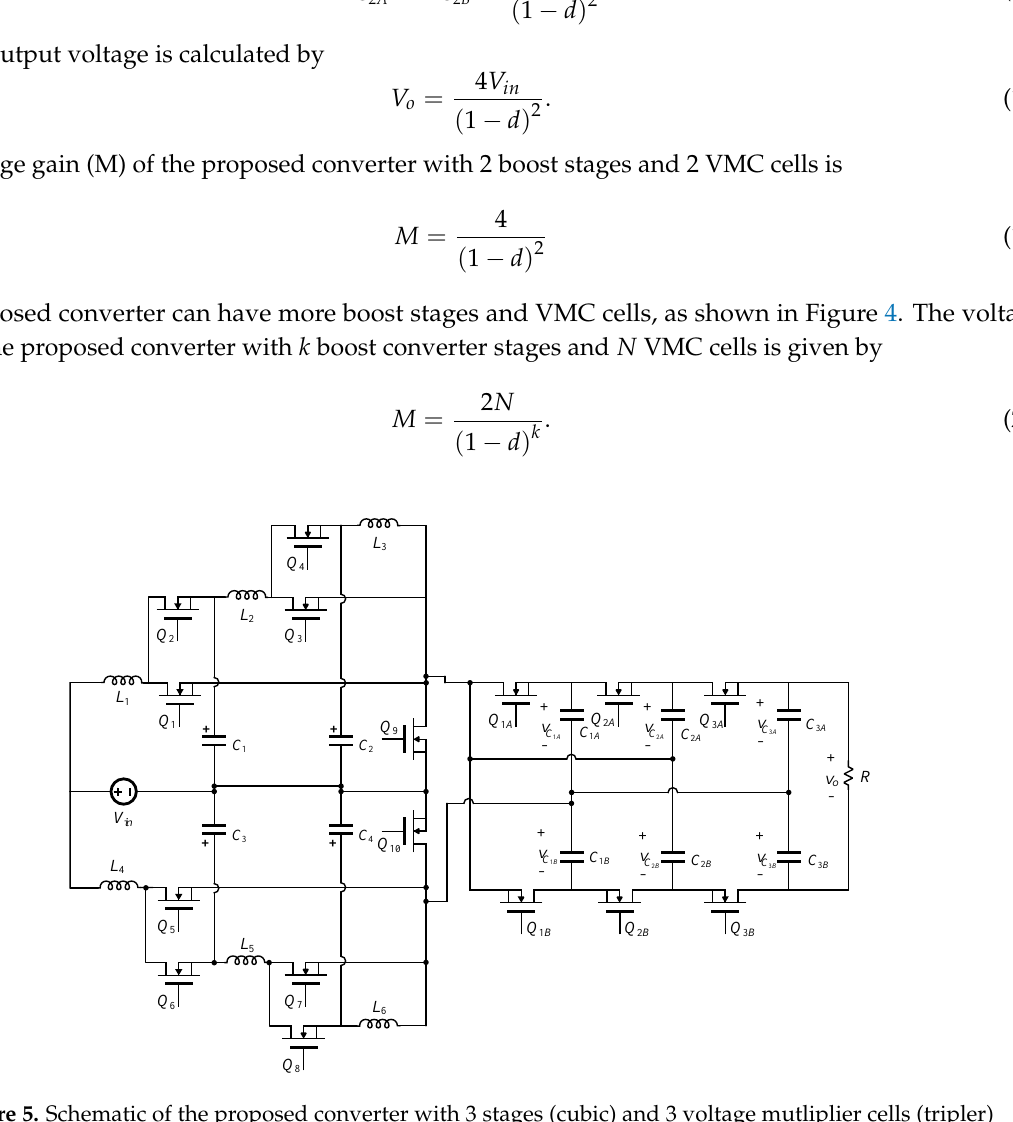
Figure 5. Schematic of the proposed converter with 3 stages (cubic) and 3 voltage mutliplier cells (tripler) and implemented using MOSFETs instead of diodes to reduce the conduction